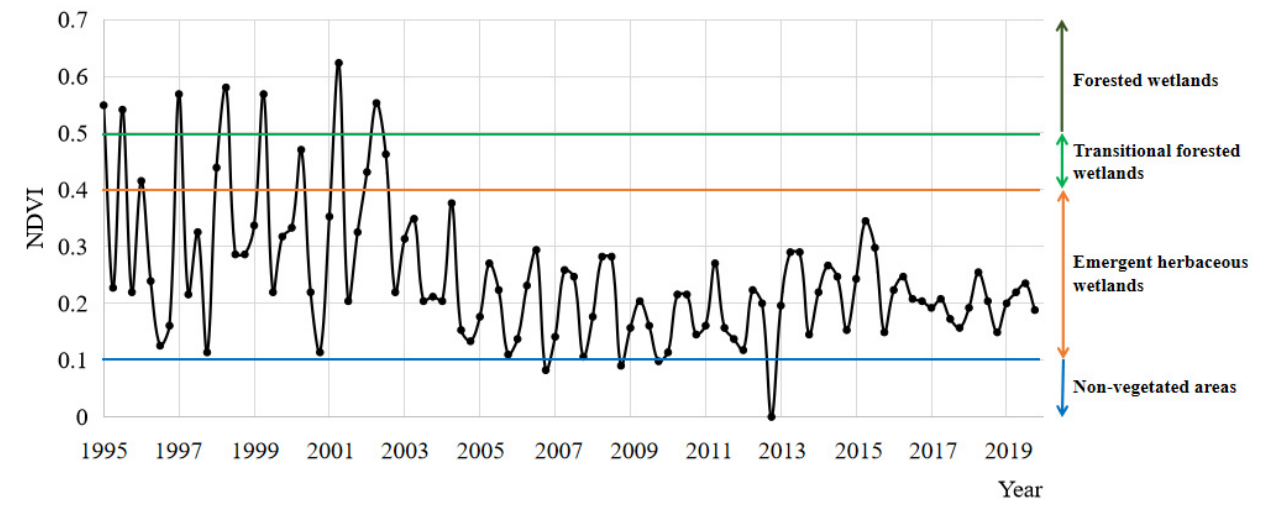
Figure 5. Evolution of seasonal NDVI values of a randomly selected pixel with the Type 2 wetland degradation within ARNWR from 1995 to 2019.